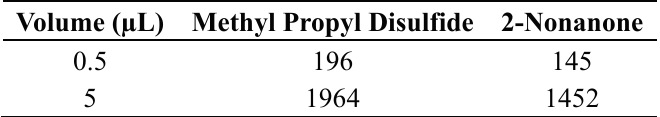
Table 3. Concentrations (ppm) of two chemicals at two different